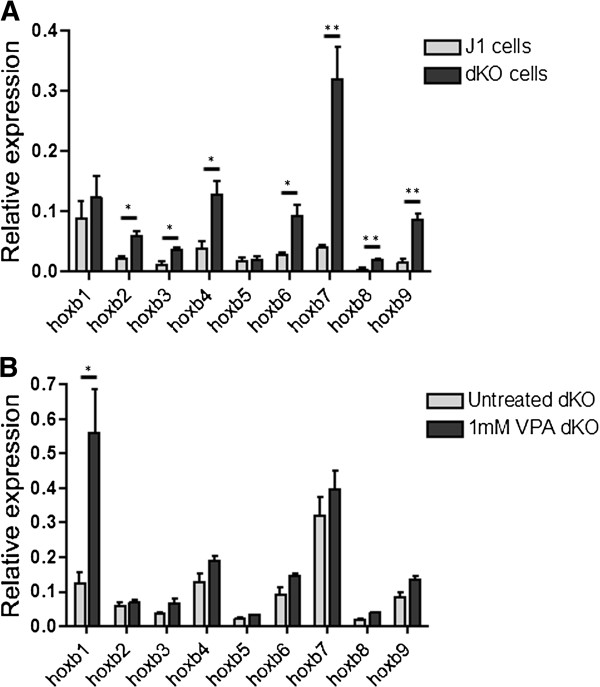
Knockout of Eed/Ring1b increases expression of Hoxb genes but only Hoxb1 responds additionally to valproic acid. (A) Transcript levels of Hoxb genes were quantified by real time-quantitative (RT-q)PCR in wild-type embryonic stem (ES) cells (J1 line) and in J1 cells in which two genes encoding Polycomb proteins (Eed; Ring1b) had been knocked out (dKO cells). Light grey bars show the expression levels in wild-type J1 cells, and dark grey bars represent expression in dKO cells. (B) dKO cells were treated for 8 h with valproic acid (VPA) (1 mM). Hoxb transcript levels in treated and untreated cells were assayed by RT-qPCR. Light grey bars represent untreated dKO cells, dark grey bars show data for VPA-treated cells. For both panels error bars represent the standard error of the mean of independent experiments (n = 3). Two-tailed unpaired t-tests were used to assess the significance of differences; *P <0.05, **P <0.01.